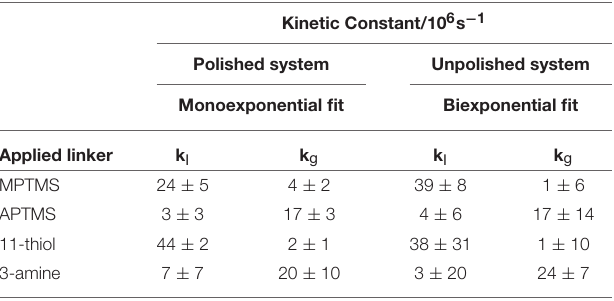
The values of unpolished systems were derived from biexponential fits. The values of k g are derived from monoexponential fits of ITO polished samples. Monoexponential fits of glass polished samples lead under consideration of K g to k I